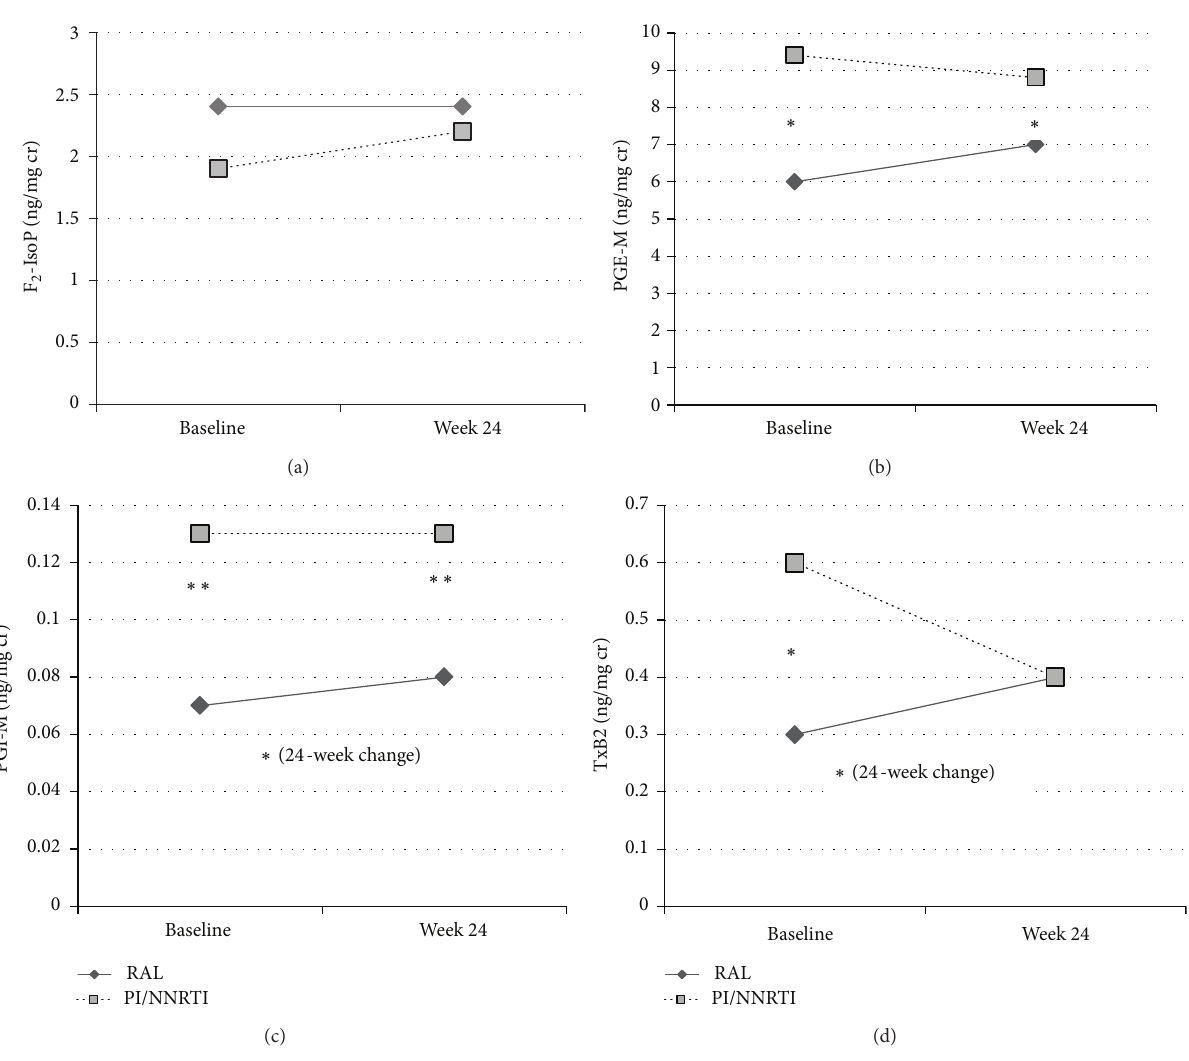
Figure 2: Median baseline and 24-week urinary eicosanoid levels by study arm. ∗ Between-group 𝑃 value < 0.1–0.05; ∗∗ between-group 𝑃 value 𝑃 = 0.08 ); Panel (c) shows PGI-M (baseline < 0.05. Panel (a) shows F 2 -IsoP; Panel (b) shows PGE-M (baseline and week 24 between-group between-group 𝑃 = 0.005 , week 24 between-group 𝑃 = 0.04 , and between-group 24-week change 𝑃 = 0.08 ); Panel (d) shows TxB 2 (baseline between-group 𝑃 = 0.09 and between-group 24-week change 𝑃 = 0.06 ). F 2 -IsoPs: F 2 -isoprostanes; PGE-M: prostaglandin E 2